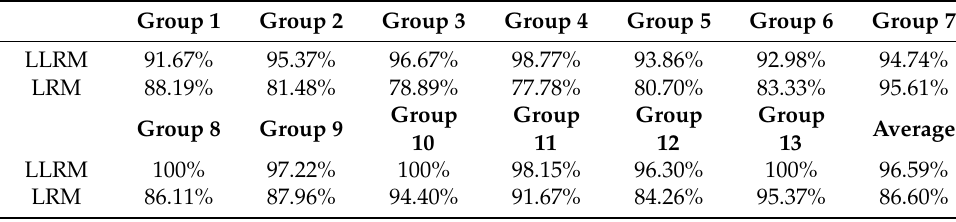
Table 7. Comparison of recognition accuracy between LLRM and LRM using SD